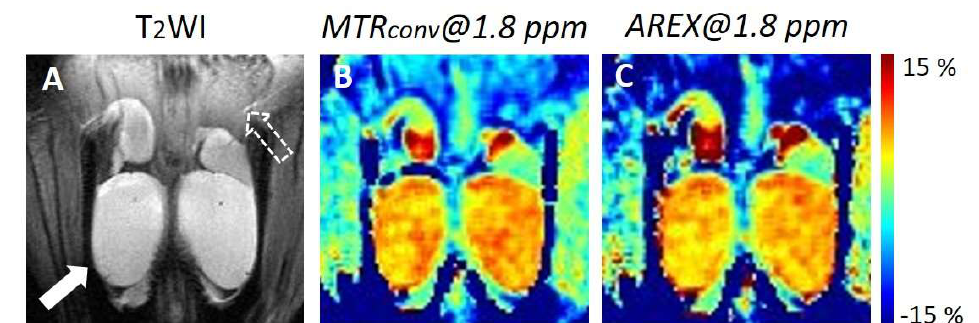
Figure 1. Representative in vivo Cr-CEST images of control mouse testes. ( A ) Anatomical T 2 WI image. The white arrow shows the testis. The white dotted arrow shows the testicular epithelium. ( B ) MTR asymmetry maps at 1.8 ppm of MTR conv . ( C ) MTR asymmetry maps at 1.8 ppm of AREX . MTR, magnetization transfer ratio; MTR conv , conventional analysis metric magnetization transfer ratio; AREX , apparent exchange-dependent relaxation; and Cr-CEST, creatine chemical exchange saturation transfer.